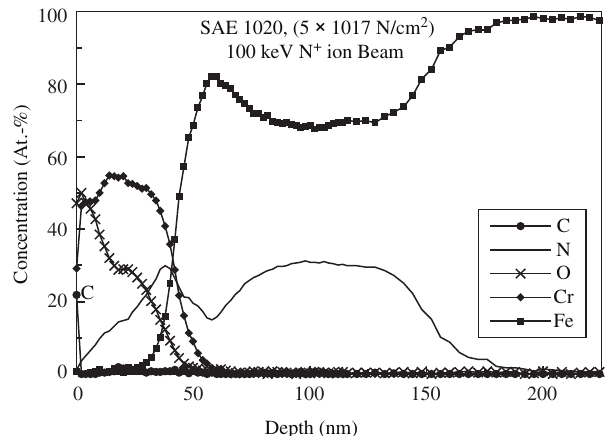
Figure 3. AES depth profile of Cr into SAE 1020 matrix, after IB bombard- ment by N+ at 100 keV energy.